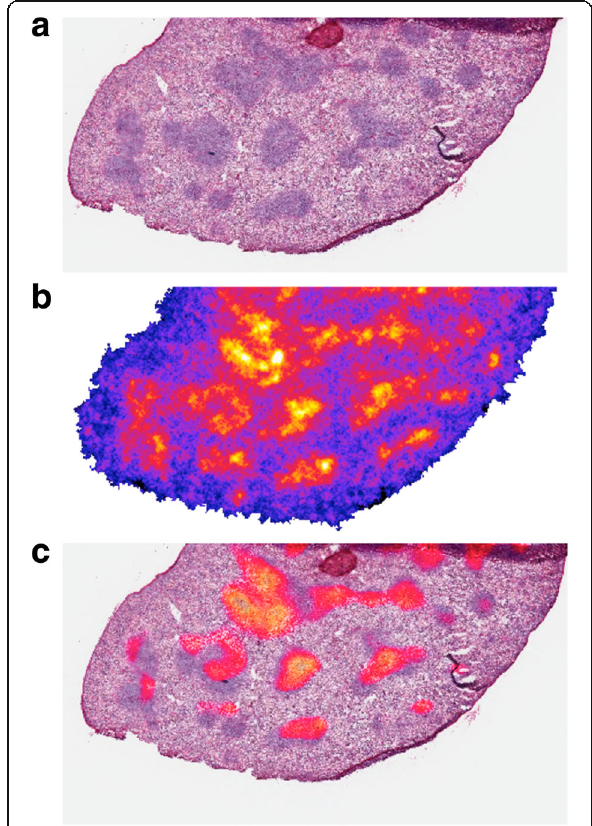
Fig. 7 Sub-region of the spleen showing a the lymphocyte-rich, white pulp region (purple staining on H&E). b The corresponding alpha-camera and c a merged image showing segmented high-intensity regions overlayed on the H&E-stained slice. Segmented regions do not exactly match the purple white pulp region due to differences in tissue processing, and the comparison is being made across two different 8- μ m-thick slices